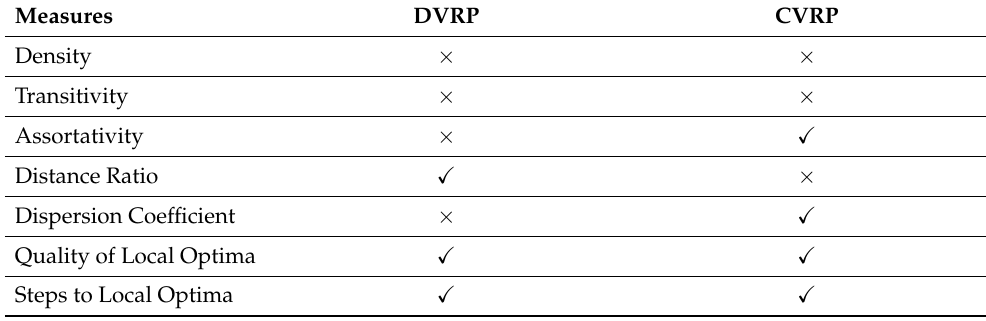
Table 2. Results for Repeated Measures ANOVA for LONA measures-Single-Attribute Perspective.